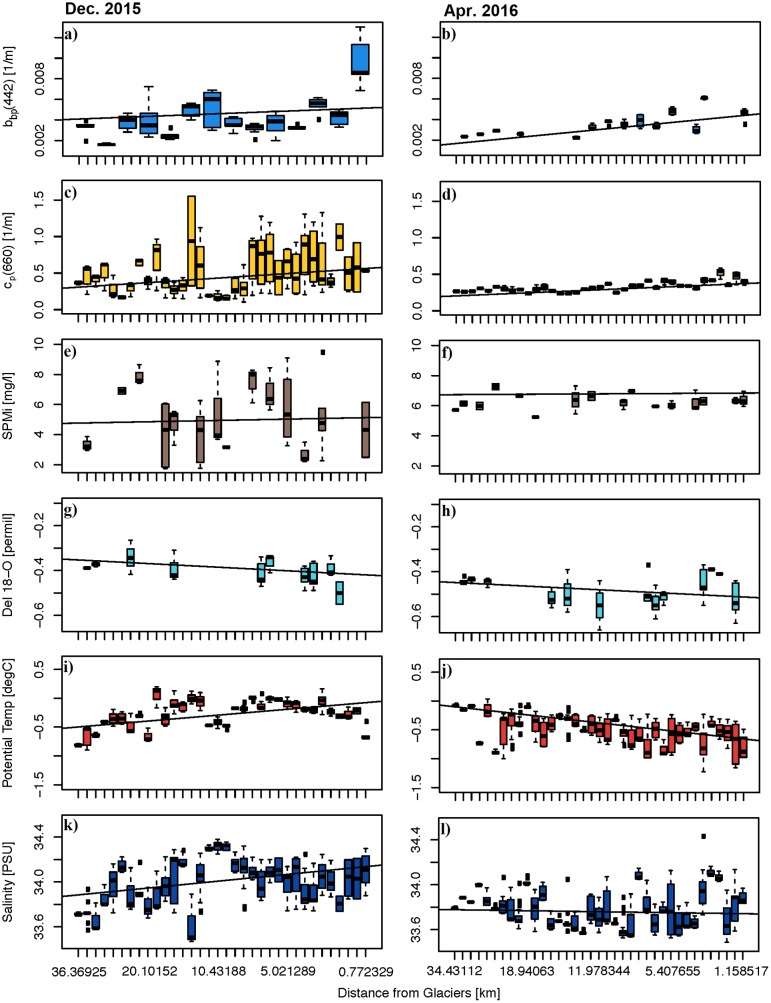
Profiles of optical and hydrographic variables.The box-whisker plots illustrate each variable’s range, variability at the sampling station, the overall trend towards the glaciers, and an overview of optical measurements and their coherence, or lack thereof, with physical variables. Each box represents a CTD profile along the fjord, and the bars on each box represent local maximum and minimum while the marker within each box represents local mean. Depth is between 0 m– 35 m and statistics pertaining to this figure are in Table 3.